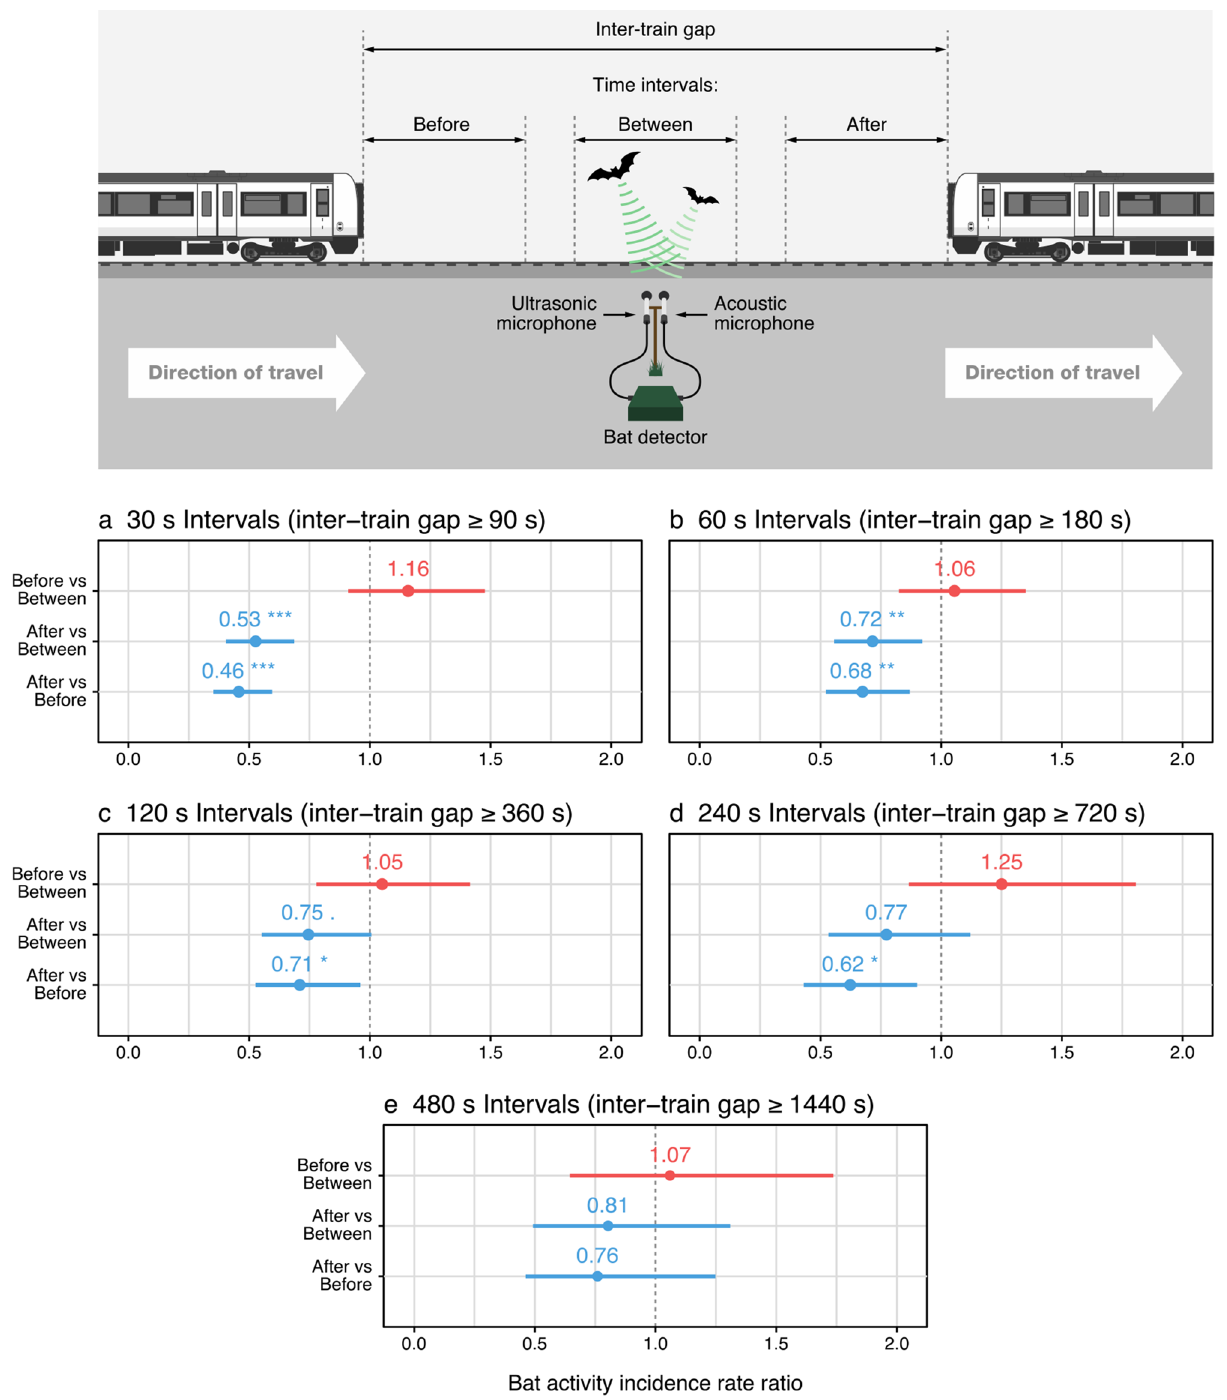
Figure 1. Schematic of the data collection setup, and incidence rate ratios (± 95% confidence intervals) comparing bat activity from before, after and between train passes in intervals of ( a ) 30 s, ( b ) 60 s, ( c ) 120 s, ( d ) 240 s and ( e ) 480 s duration. Each plot row provides the incidence rate ratio of the first interval type (data-point and confidence interval) against the second (vertical dotted line) noted on the y-axis. Asterisks indicate the significance level of a given comparison, (no asterisk—not significantly different; . p ≤ 0.1 *p ≤ 0.05; **p ≤ 0.01; ***p ≤